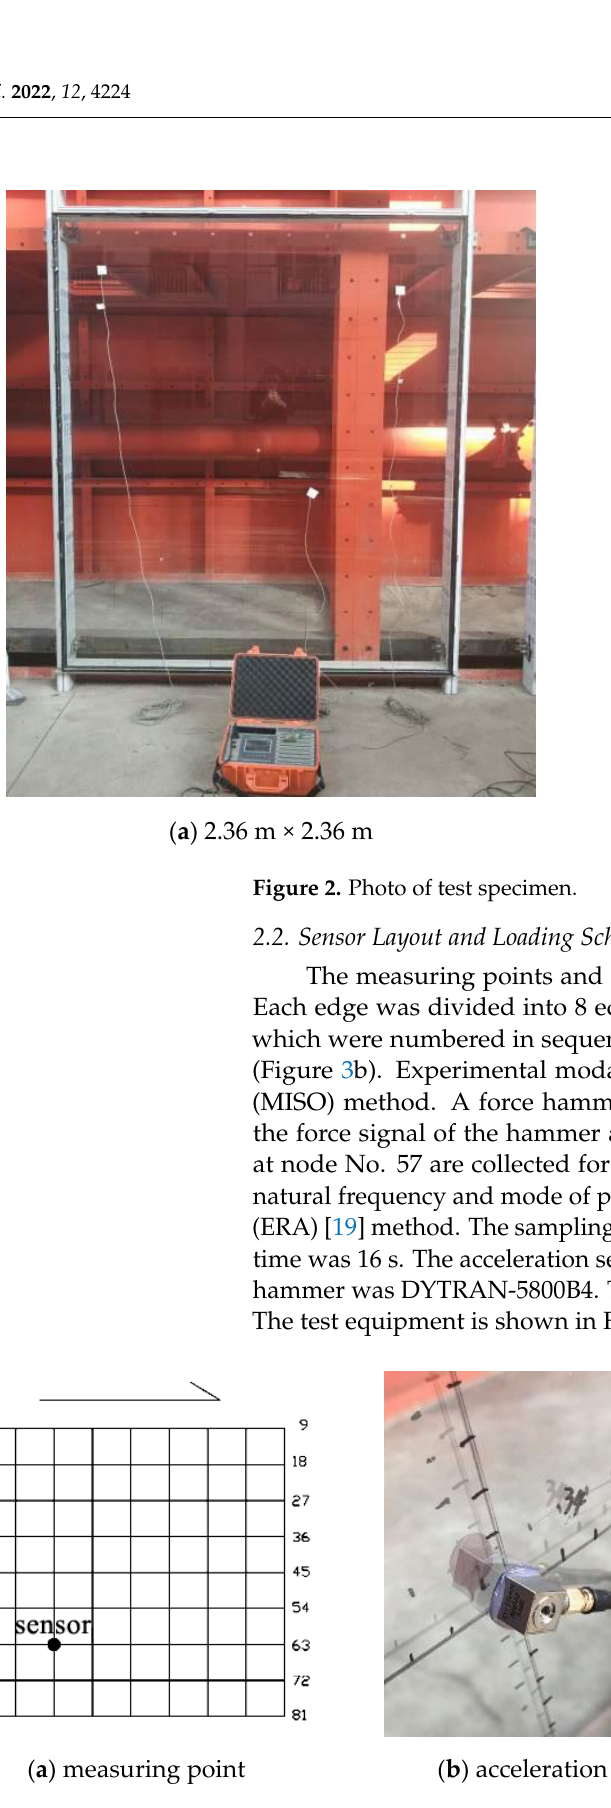
Figure 3. Impulse points and field photos of modal recognition.